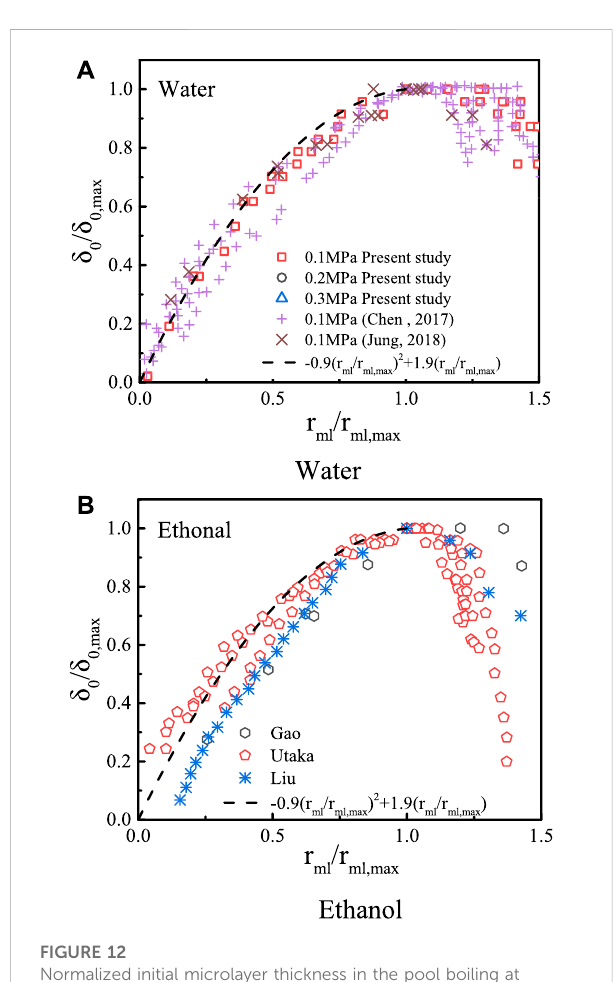
FIGURE 12 Normalized initial microlayer thickness in the pool boiling at atmospheric